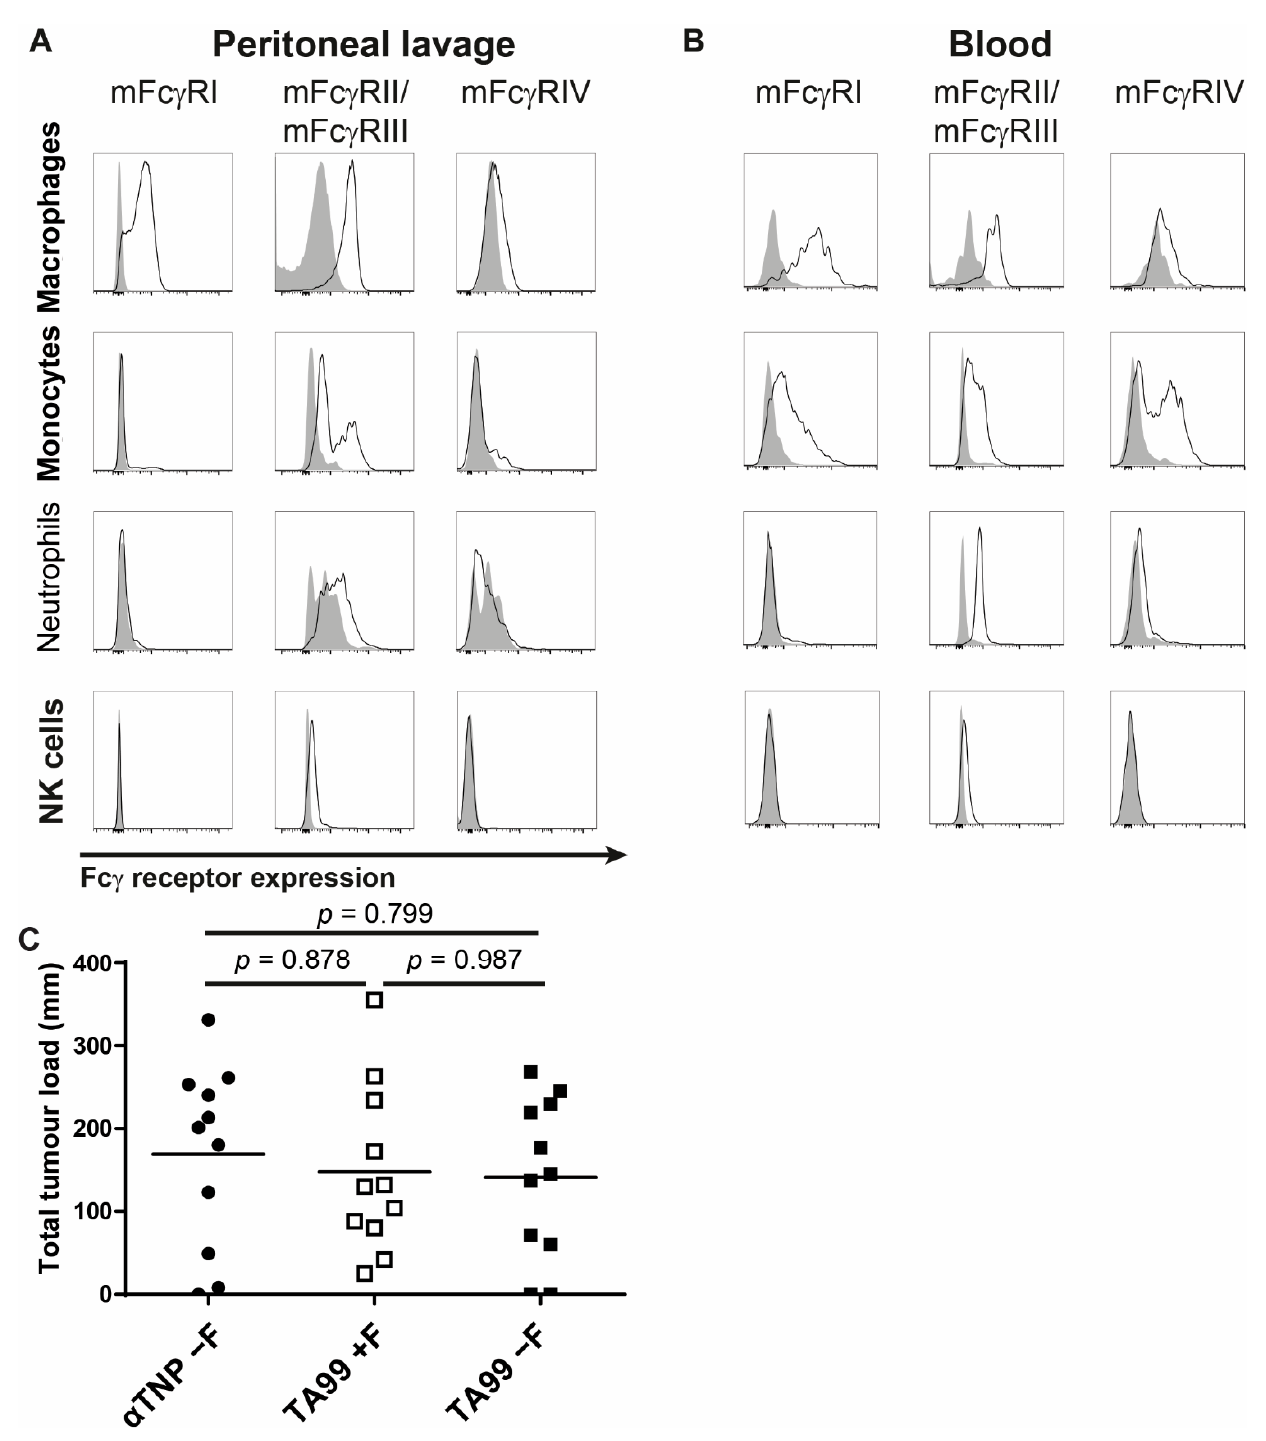
Figure 5. Affinity plots for afucosylated human IgG1 to mouse Fc γ R: Lack of fucose in the Fc domain results in increased binding to mouse Fc γ RIV. Experiment was carried out as described for Figure 4, with ( A ) Sensorgrams and ( B ) derived affinity plots for 4 different ligand (Fc γ R) concentrations as indicated. ( C ) The derived KD from each affinity plots for fucosylated hIgG1 (Figure 4B) and afucosylated IgG1 from ( B ) and Rmax of each ligand concentration plotted for interpo- lation of KD for both fucosylated and afucosylated IgG1 to a constant Rmax of 500 (vertical lines, tabulated in Table 1).